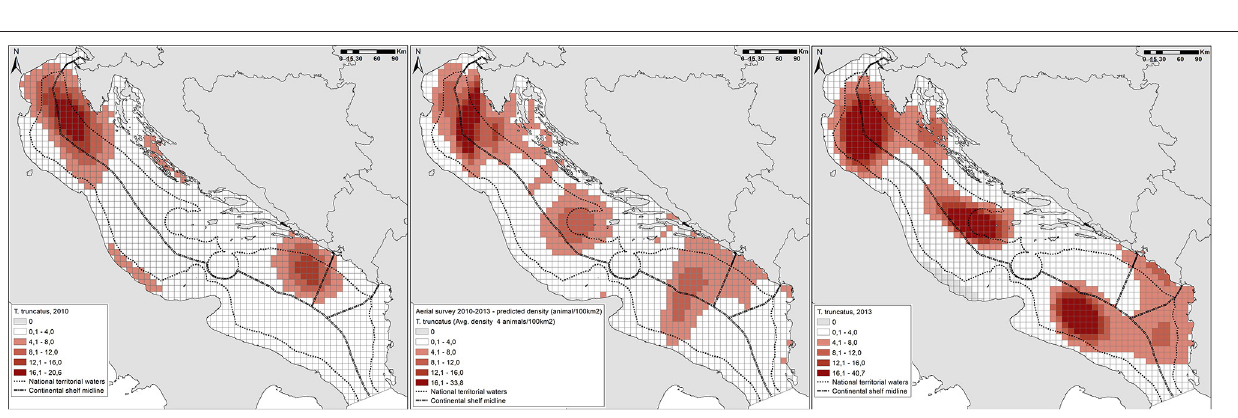
northern Adriatic) and/or influx of specimens of the pelagic ecotype (especially in the south Adriatic; Gaspari et al.,